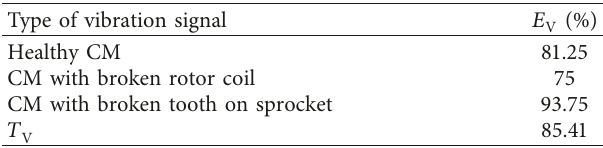
Table 9: The results of recognition of vibration signals—the MSAF- RATIO-50-SFC and the backpropagation neural network were used.